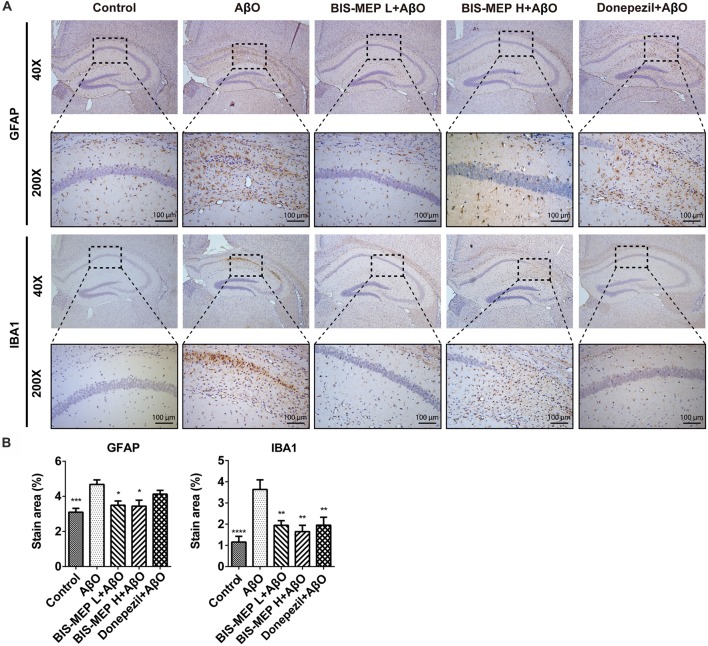
Effects of BIS-MEP on inflammatory nerve cells in the brains of AD model mice. (A) Images of immunohistochemical staining inflammatory biomarkers of activation in representative sections of the hippocampus from each group (40× magnification). Astrocytes and microglia were labeled with glial fibrillary acidic protein (GFAP) and ionized calcium-binding adapter molecule 1 (IBA1), respectively. Representative regions enclosed in rectangles are shown at 200× magnification for specification. (B) The quantitative analysis of the percentage of area occupied by activated astrocytes stained with GFAP and activated microglia stained with IBA1. Image-Pro Plus software was used to semi-quantitatively measure the percentage of activated astrocytes and microglia. Bars in the chart represent the means ± SEM for each group (n = 7–10). Significant differences between the AD model group and other groups are indicated by asterisks. *P < 0.05, **P < 0.01, ***P < 0.001, and ****P < 0.0001.